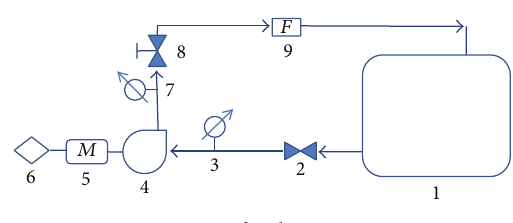
Figure 5: Centrifugal pump test